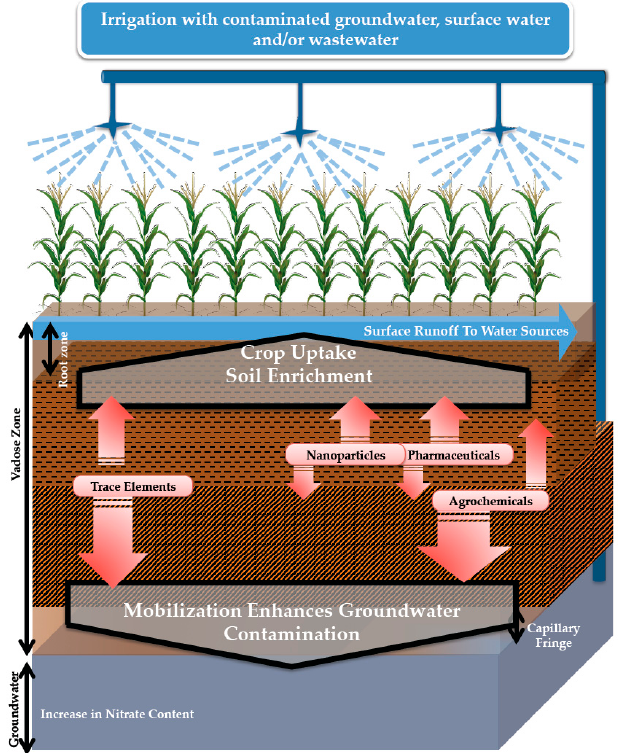
Figure 2. A conceptual model of the impact of inadequate quality of irrigation water sources on soil and crop quality.